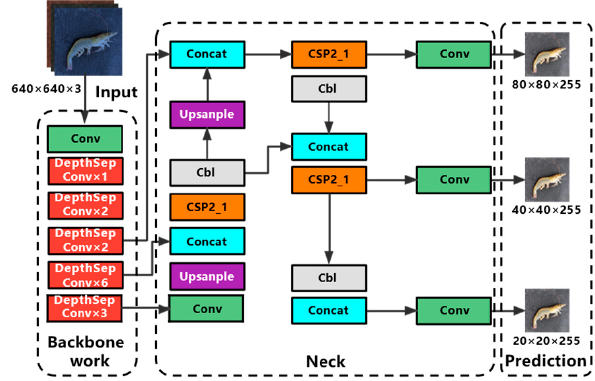
Figure 2. Network structure diagram of